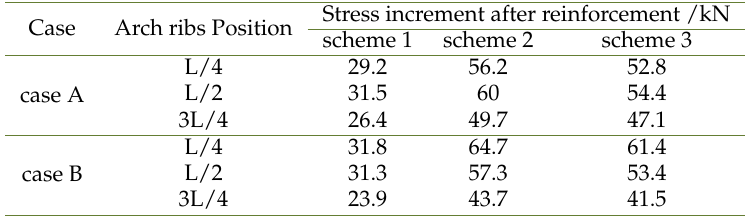
Table 3. Comparison of suspender axial force